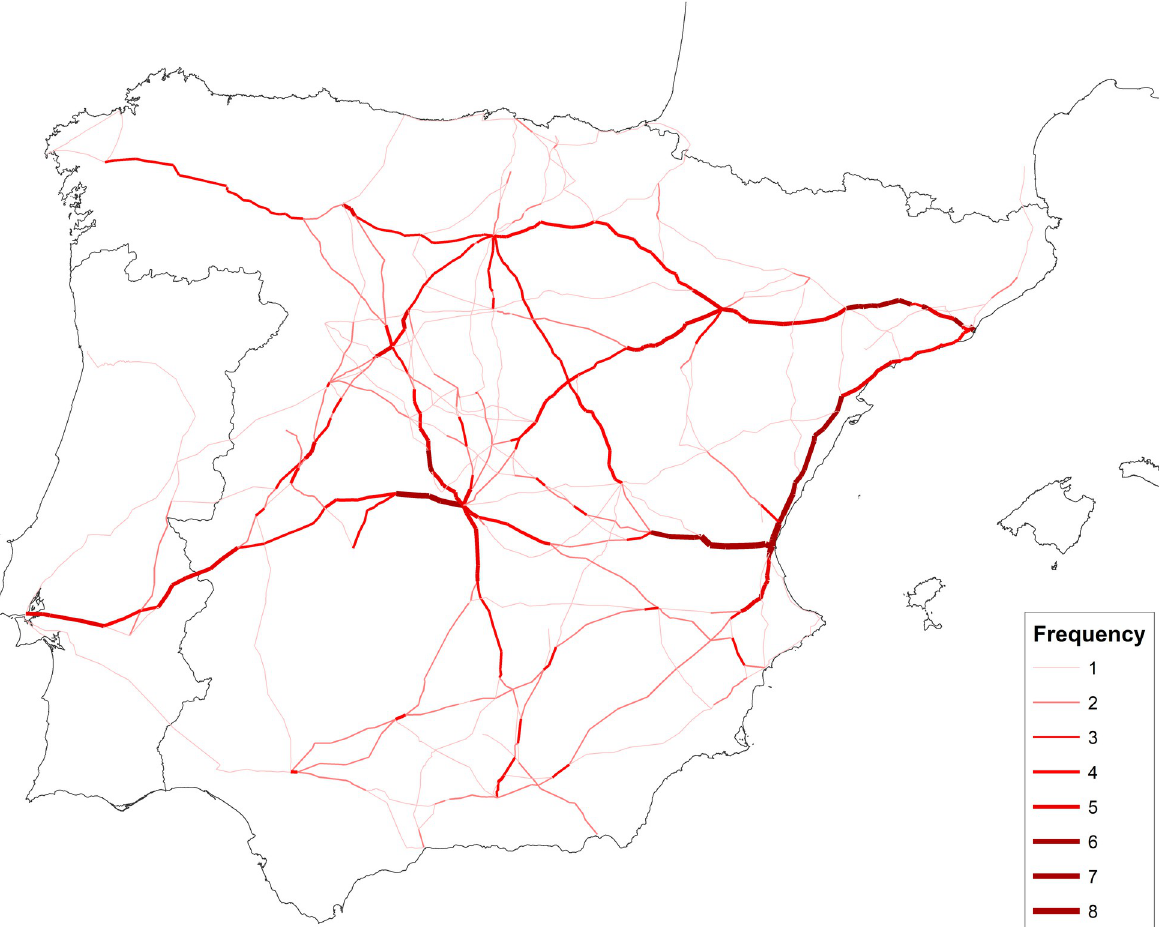
Fig 7. Roads most frequently described in Villuga’s itinerary. Notes: Villuga’s itinerary does not offer an explicit classification of the importance of roads, but the frequency with which the road sections appear can serve as an approximation. Source : Villuga [63] and own elaboration. Base map from the Centro Nacional de Informacio´n Geogra´fica